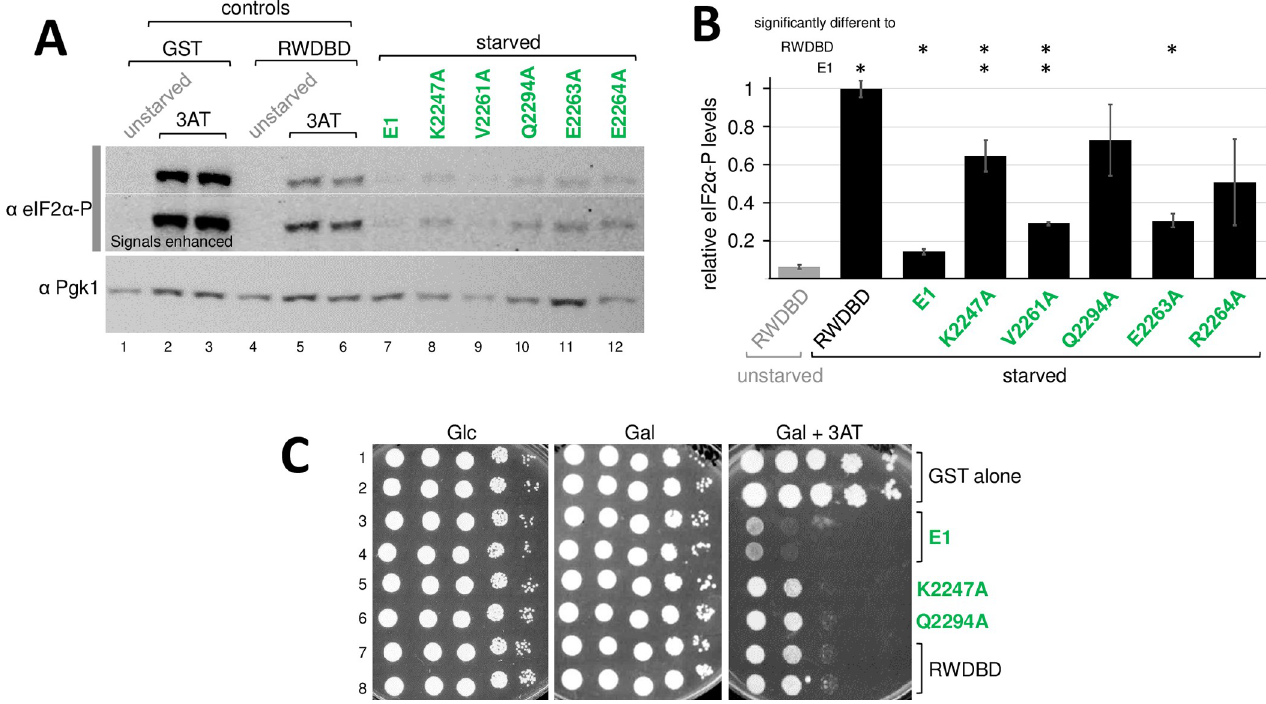
Fig 5. Analysis of multiple amino acid substitutions targeting residues that each enhanced the dominant negative effect of the RWDBD. (A) Strains overexpressing RWDBD variants or GST alone as indicated were subjected to immunoblotting assays to determine eIF2 α -P levels as done in Fig 3. At least five independent experiments were conducted, and a representative result is shown. (B) The relative level of eIF2 α -P level in (A) was determined as done in Fig 3, and standard errors are shown as error bars. Values significantly different to that of the RWDBD are indicated with an asterisk (Student two-tailed t-test, p < 0.05). (C) The strains in (A) were subjected to semi-quantitative growth assays as done in Fig 1A. At least three independent experiments were conducted, and a representative result is